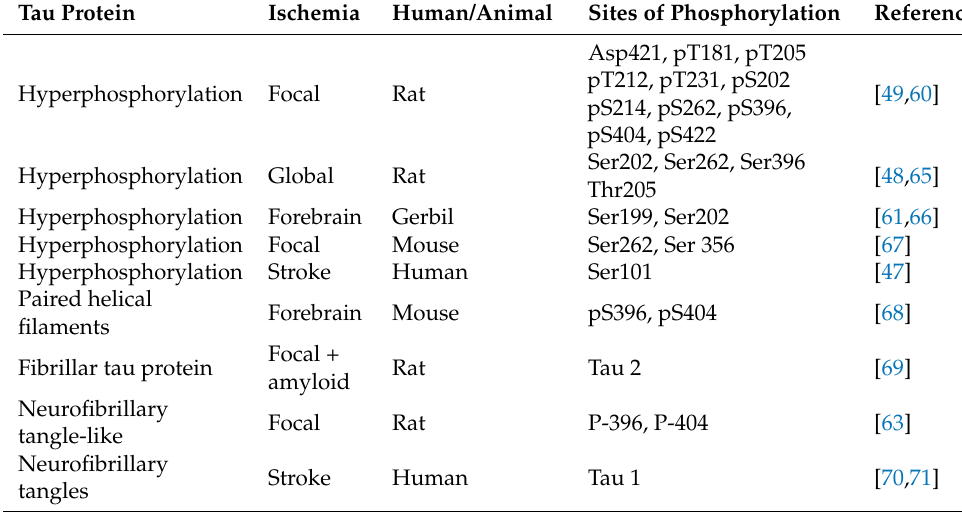
Table 2. Hyperphosphorylation and the structure of the tau protein after brain ischemia. Tau Protein Ischemia Human/Animal Sites of